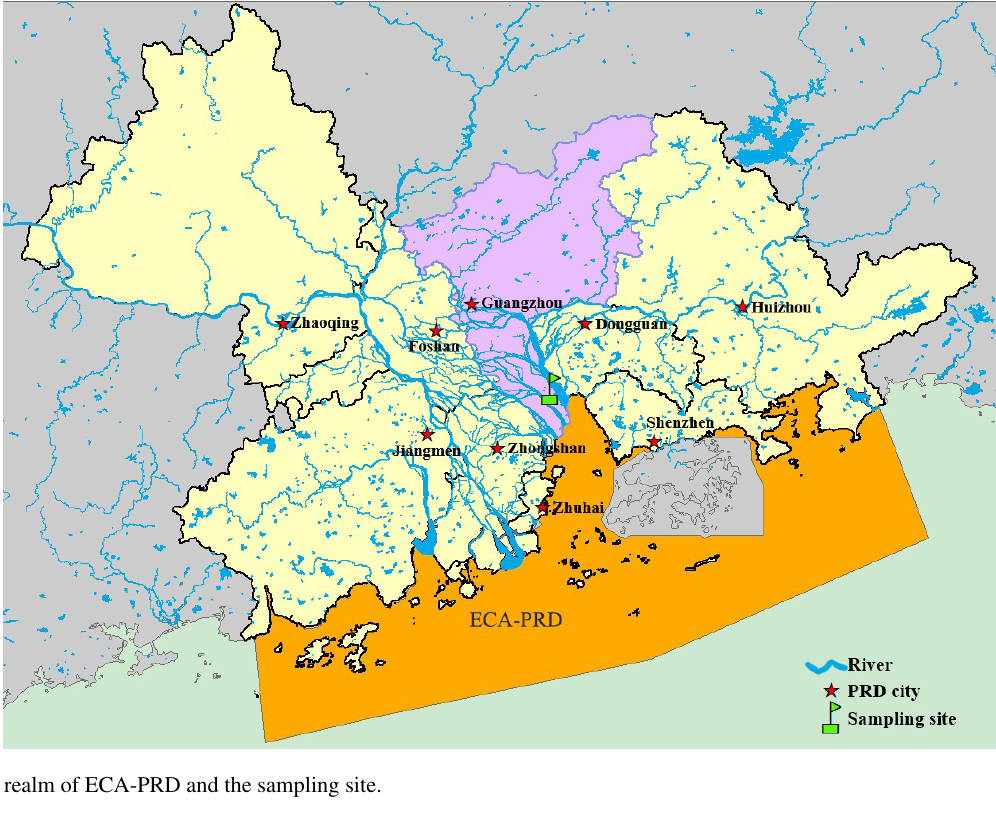
Figure 1. The realm of ECA-PRD and the sampling site.